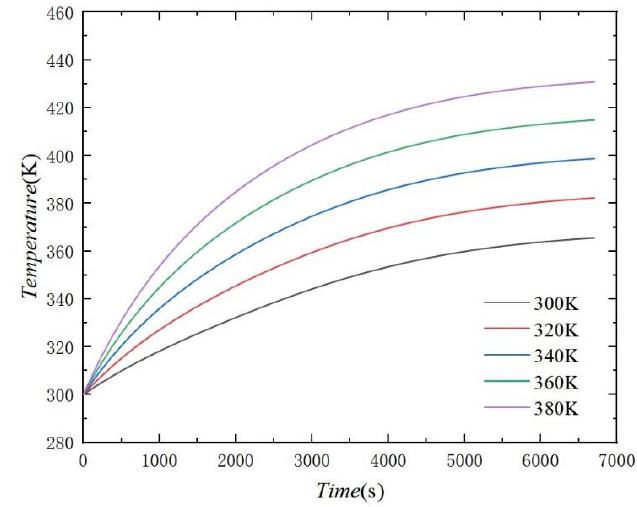
Figure 13. Temperature of accessory 1 with different fuel temperatures.